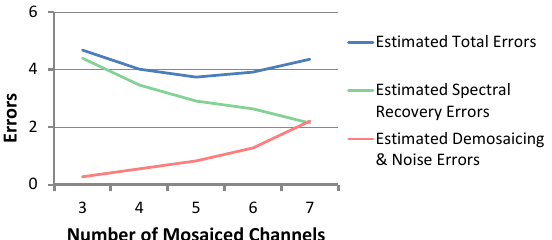
Figure 13. Our estimated error (spectral recovery error, demosaicing error and imaging noise) on “CAVE” spectral dataset [38] with a different number of mosaiced channels. The errors reveal the optimal number of channels to be around 5–6. Here, we use the MSFA and demosaicing method in [26].